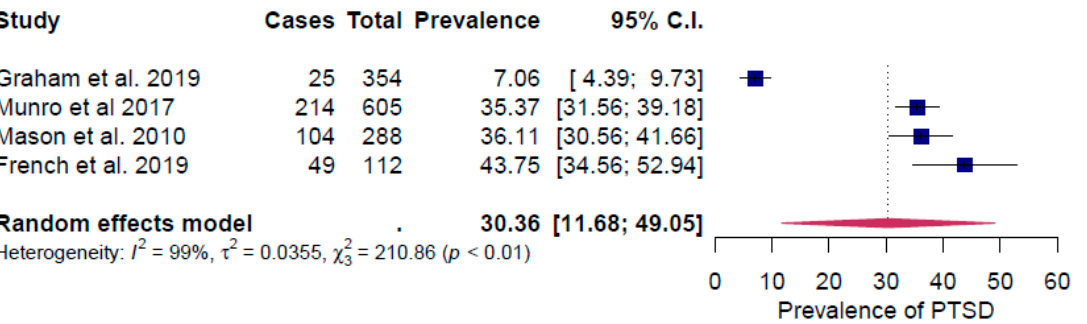
Figure 4. Forest plot of the prevalence rate of Post-Traumatic Syndrome Disorder (PTSD).